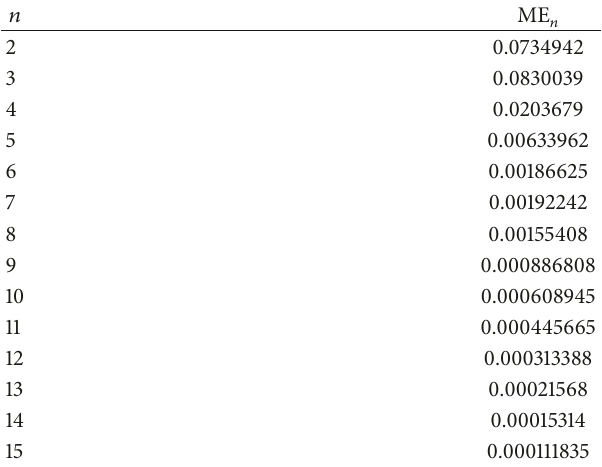
Figure 10: ER 𝑛 (𝑥) when 𝑛 = 10 obtained by the Duan-Rach modified ADM for 𝛼 = 3.2 (dot-dash), 𝛼 = 3.4 (dot line), 𝛼 = 3.6 (dot-dot-dash), and 𝛼 = 3.8 (dash line). Table 2: For 𝑐 = 0.5 and 𝛼 = 2 , maximal errors ME 𝑛 for 𝑛 = 2, 3, .. ., 15 obtained by the Duan-Rach modified ADM.